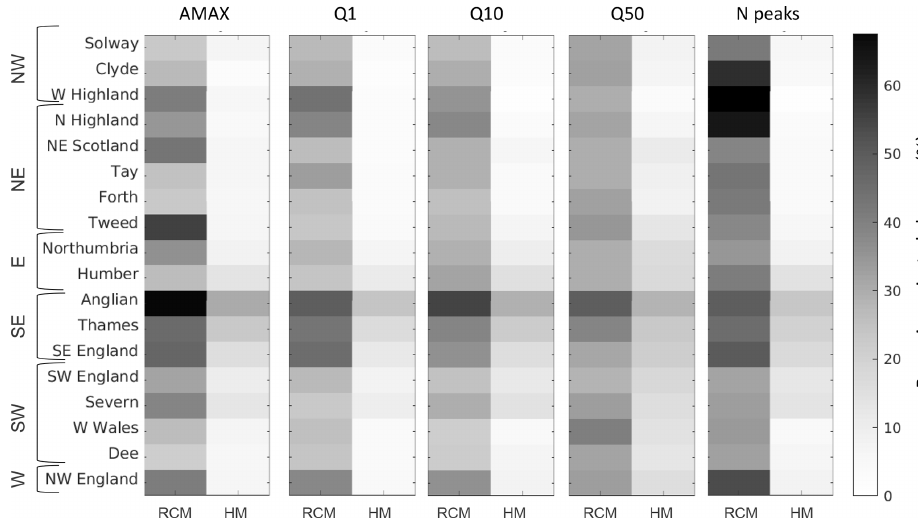
Figure 7. Relative uncertainties from inclusion of different RCM and hydrological model (HM) parameter sets. The RCM range was calcu- lated as the full range in regional-average changes between the RCMs, using the median of all HM parameter sets. Similarly, the HM range was calculated using the median output of all